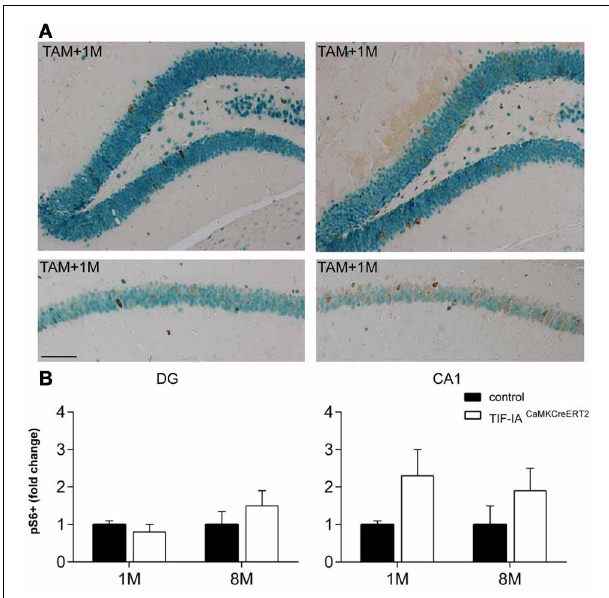
FIGURE 9 | mTOR signaling is active in control and TIF-IA CaMKCreERT2 mutant mice. (A) Representative images of the immunostaining with phospho-S6 (brown) and NeuN (green) antibodies in DG and CA1 on paraffin sections of control and TIF-IA CaMKCreERT2 mutant mice 1 month after tamoxifen. (B) Quantification of phospho-S6 positive neurons 1 and 8 months after tamoxifen in DG (left panel) and CA1 (right pane); n = 5. Scale bar: 120 μ